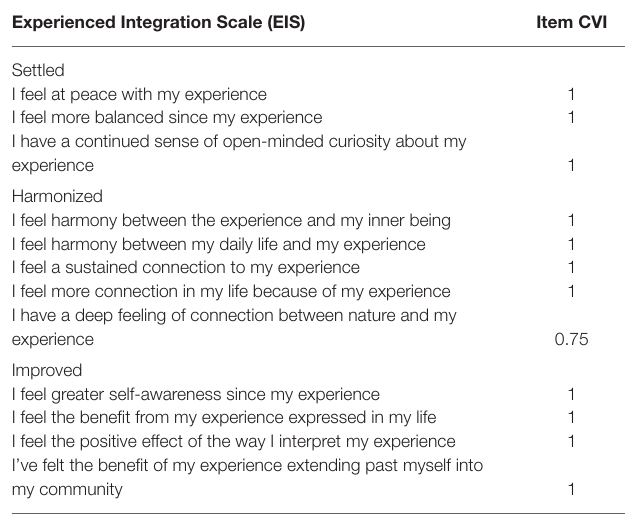
TABLE 3 | Experienced integration scale CVI results.